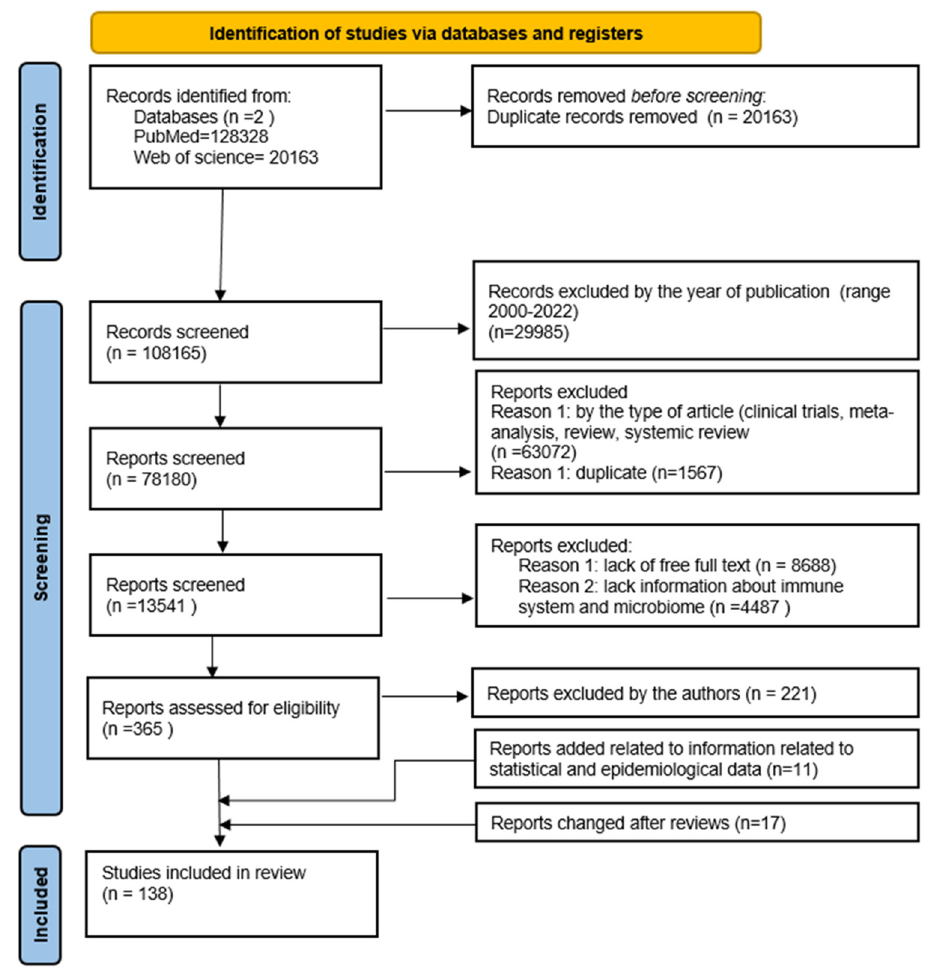
Figure 2. The flow diagram of the study’s inclusion and exclusion criteria.